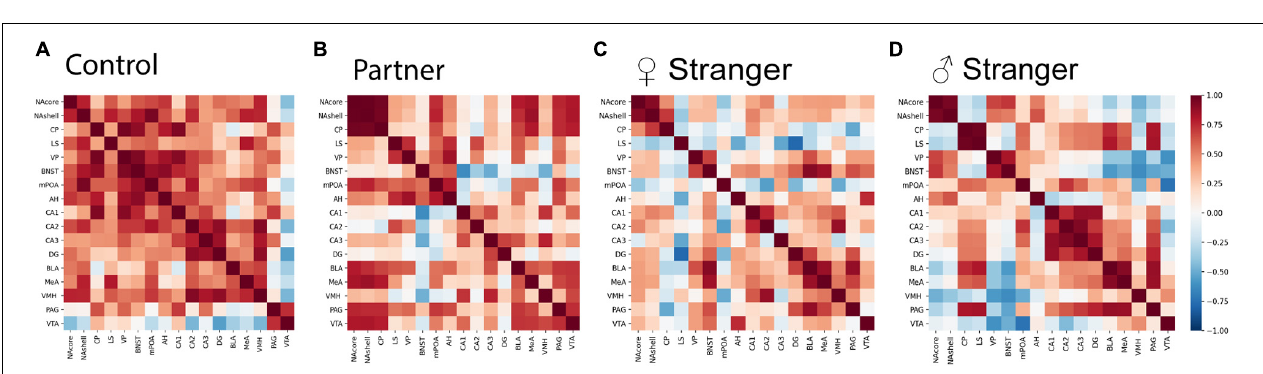
FIGURE 3 | Pair-bonded male prairie voles exposed to social stimuli had an increased density of c-Fos expression in eight of the thirteen regions presented in the SDM network. Compared to male prairie voles not exposed to a social stimulus, there was a higher density of Fos-positive cells for one of the three social stimuli in the ventral pallidum (VP; A ), lateral septum (LS; B ), bed nucleus of the stria terminalis (BNST; C ), medial preoptic area (mPOA; D ), anterior hypothalamus (AH; E ), medial amygdala (MeA; F ), ventromedial hypothalamus (VMH; G ), and ventral tegmental area (VTA; H ). Groups labeled with unique alphabetical letters differed significantly by post hoc SNK test in which a significant main effect was detected in the ANOVA ( p < 0.05). If groups share any letter, there was no significant difference between them. Thus, “a” was different from “b,” but “ab” was equal to both “a” and “b” (control, n = 7; partner, n = 9; opposite-sex stranger, n = 9; same sex stranger, n = 9).